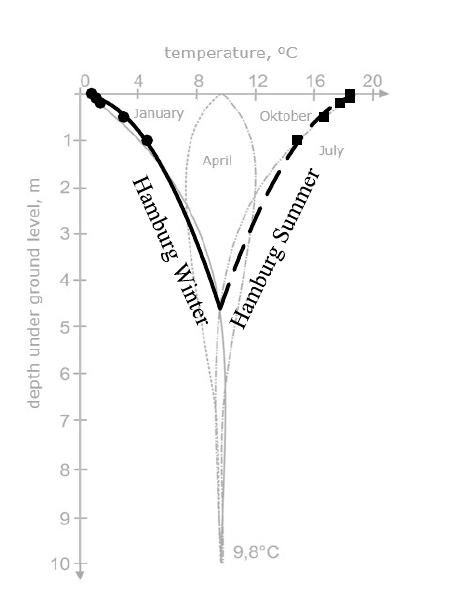
Fig. 1. Ground temperature profiles of the city of Hamburg compared with curves according to Dahlem without ground water [23],